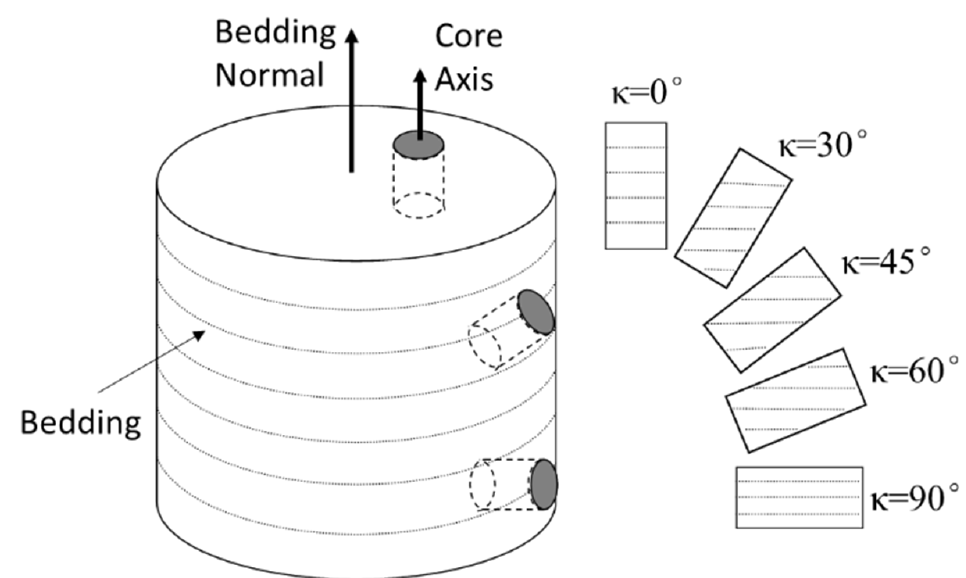
Figure 4. Cutting angles of the shale core samples.